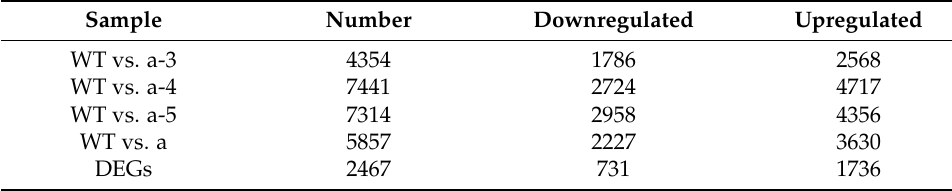
Figure 6. Statistical analysis of DEGs among the WT, a-3, a-4, and a-5 lines, based on the transcriptomic analysis of Larix kaempferi . ( A ) Venn diagram of DEGs common to the WT, a-3, a-4, and a-5. ( B ) The numbers of upregulated and downregulated DEGs. Table 3. Data of differentially expressed genes